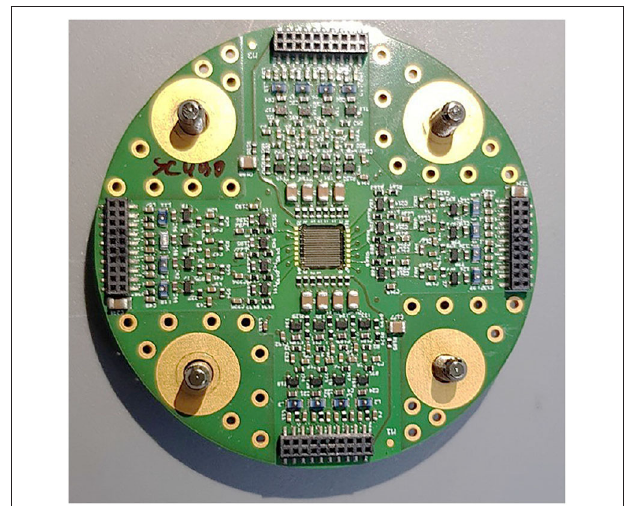
FIGURE 7 | Picture of one of the HADES start detector (Courtesy of Dr. Jerzy